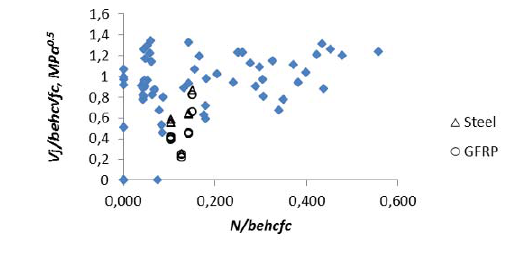
Figure 14. Influence of column reinforcement ratio.